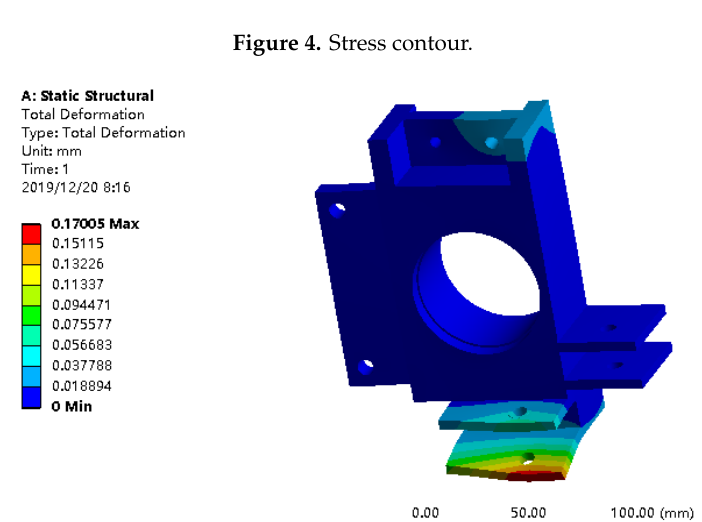
Figure 5. Deformation contour.